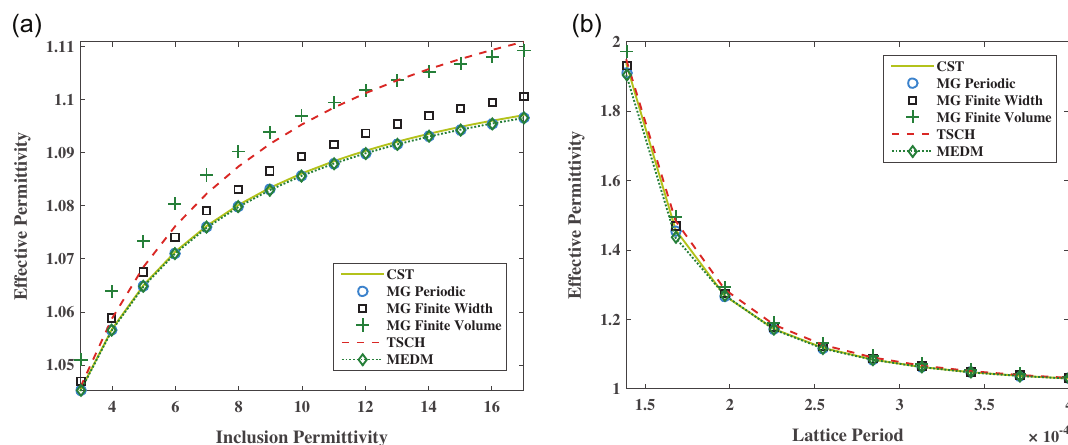
Figure 2. Effective permittivity extraction of a periodic material using various homogenization techniques. We used full wave-finite element method based Nicolson Ross Weir (FEM-NRW) technique, Maxwell-Garnett (MG) periodic, MG finite along one dimension ( z -direction), MG finite (finite along each direction), TSCH, and the proposed technique (MEDM) in order to extract the effective parameters. A cubic sample of the composite is considered, and the full geometric and simulation settings are given in Table 1. (a) Effective permittivity as a function of the permittivity of the inclusion material. The lattice period d is three times the edge-length of the basis a . (b) Effective permittivity as a function of the lattice period. The relative permittivity of the inclusion is 6.